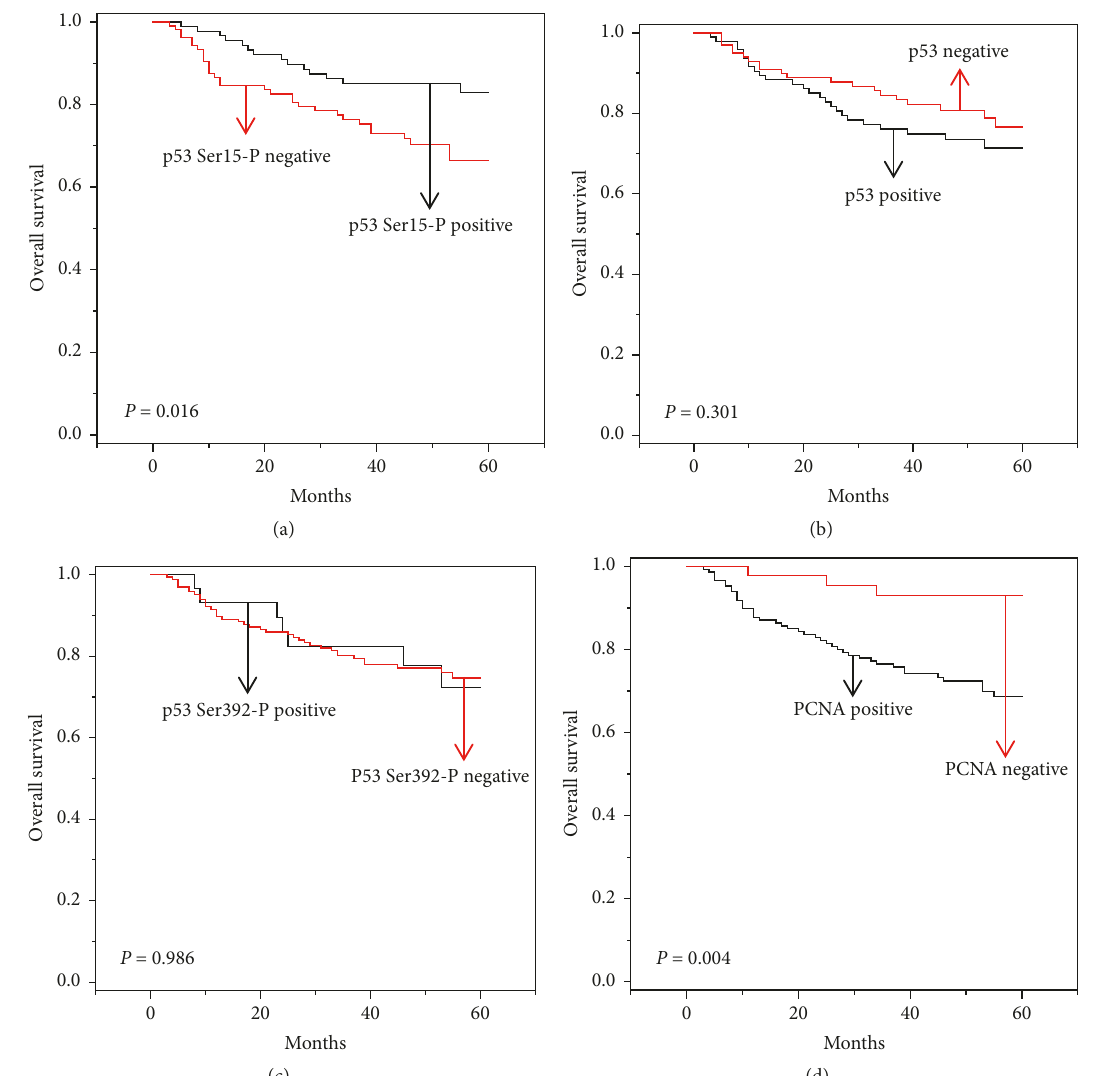
Figure 2: Five-year overall survival (OS) curves of HCC patients with positive or negative expression of p53, p53 Ser15-P, p53 Ser392-P, and PCNA by Kaplan-Meier Curve . Black lines are the positive individuals, and red lines are the negative individuals. (a) OS graph of p53 Ser15- P–positive and –negative individuals. (b) OS graph of p53-positive and -negative individuals. (c) OS graph of p53 Ser392-P–positive and –negative individuals. (d) OS graph of PCNA-positive and -negative individuals. P , P value from log rank